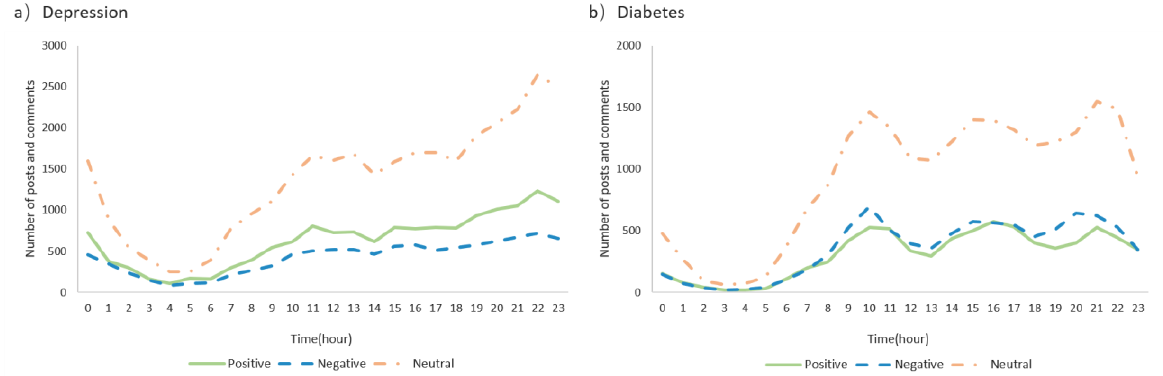
Figure 7. Distribution of positive, negative, and neutral texts by hour of the day in online ( a ) depres- sion and ( b ) diabetes